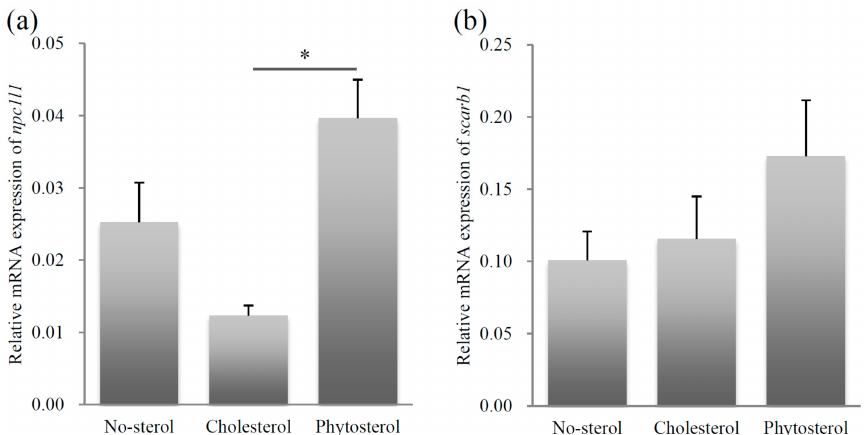
Figure 2. Relative mRNA expression levels of sterol uptake related genes, npc1l1 ( a ) and scarb1 ( b ). Left column: no-sterol group, Middle column: cholesterol-fed group, Right column: sitosterol-fed group. Data were expressed as mean ± standard error (SE) ( n = 10, per group). Statistically significant difference is shown as * p < 0.05.